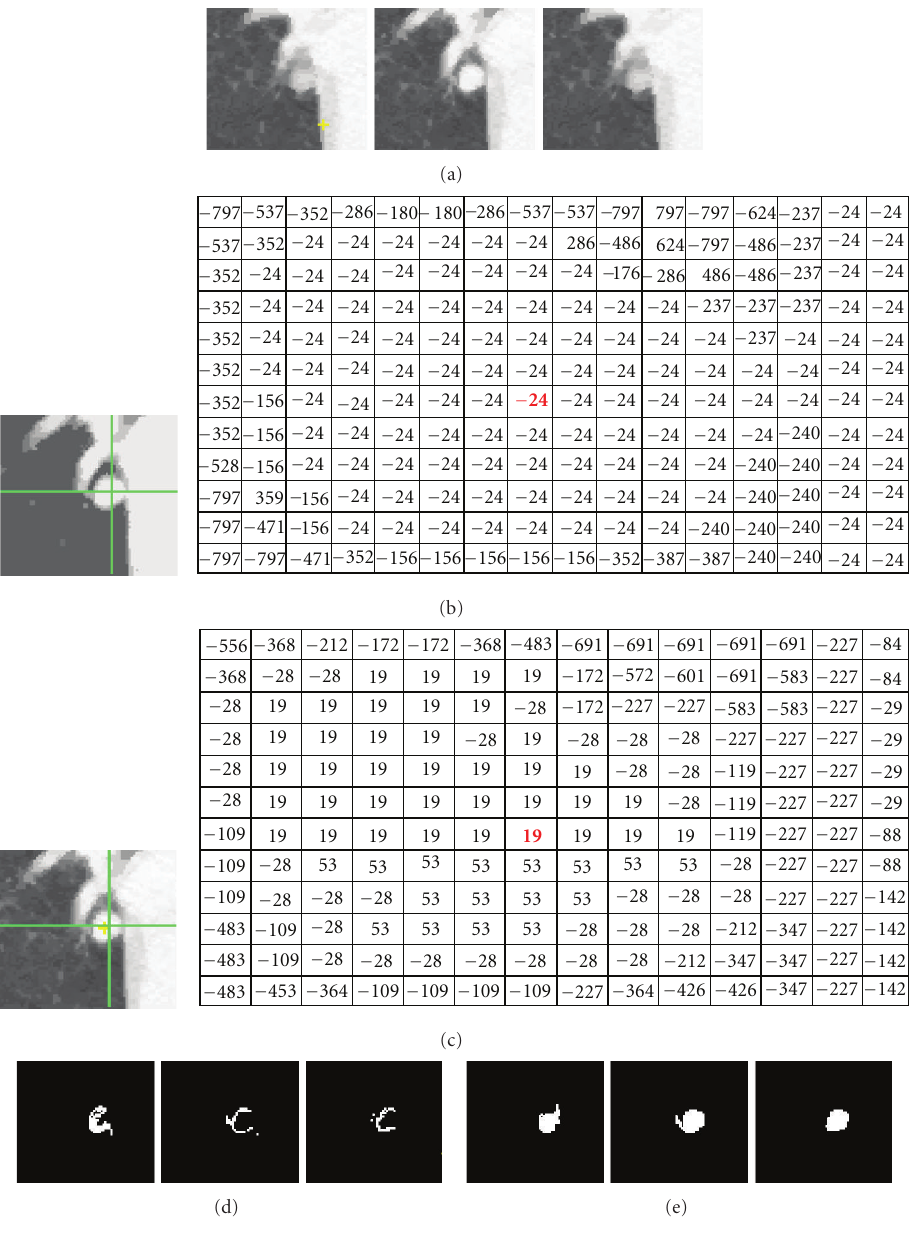
Figure 10: An example of segmentation of an attached nodule. (a) Original 3D nodule on three contiguous slices; (b) intensity mode map and its corresponding intensity mode values based on 4D mean shift clustering (without shape); (c) intensity mode map and its corresponding intensity mode values based on 5D mean shift clustering (with shape). (d) and (e) segmentation results without and with the shape feature (proposed method),